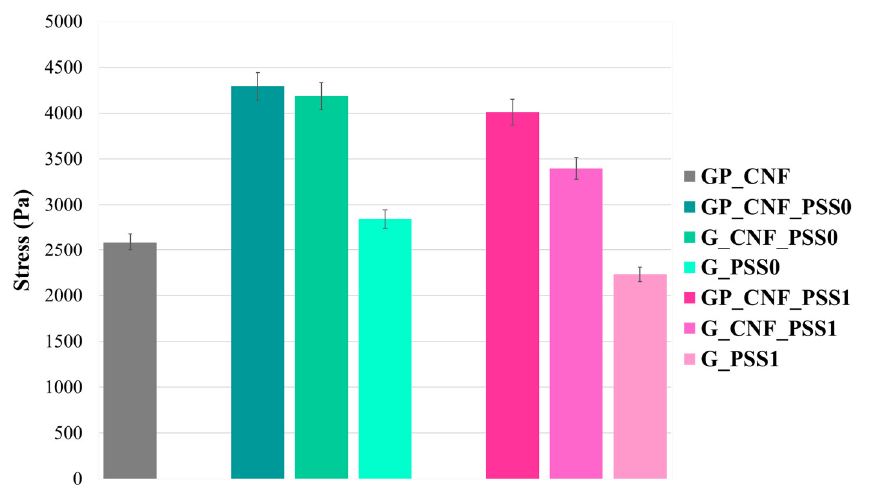
Figure 2. Comparative results of compressive mechanical tests.